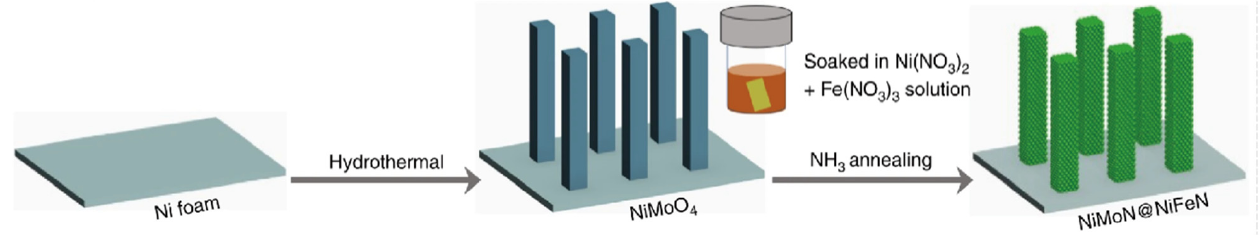
Figure 11. The schematic diagram of NiMoN@NiFeN preparation [58].